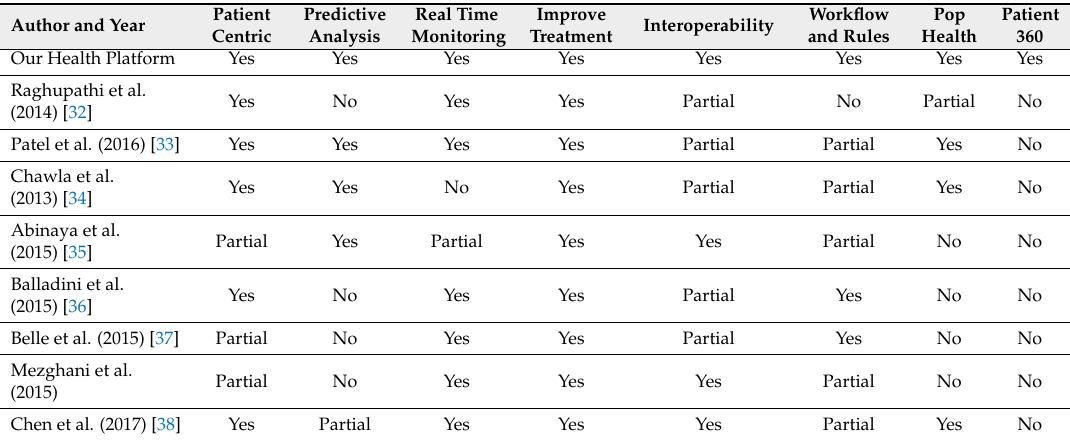
Table 15. Comparison of healthcare big data